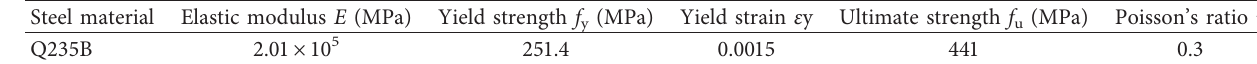
Figure 2: Geometry of the specimen. (a) Layout of the columns, braces, and shear walls. (b) Layout of the beams and shear walls. (c) Elevation of the specimen. Table 2: Properties of